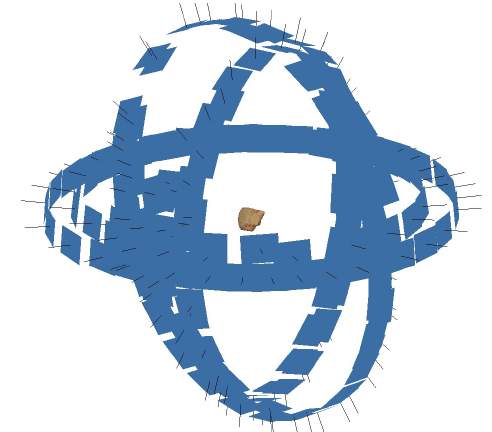
Figure 7. Photoscan image orientation of the fragment with Komòs scene.